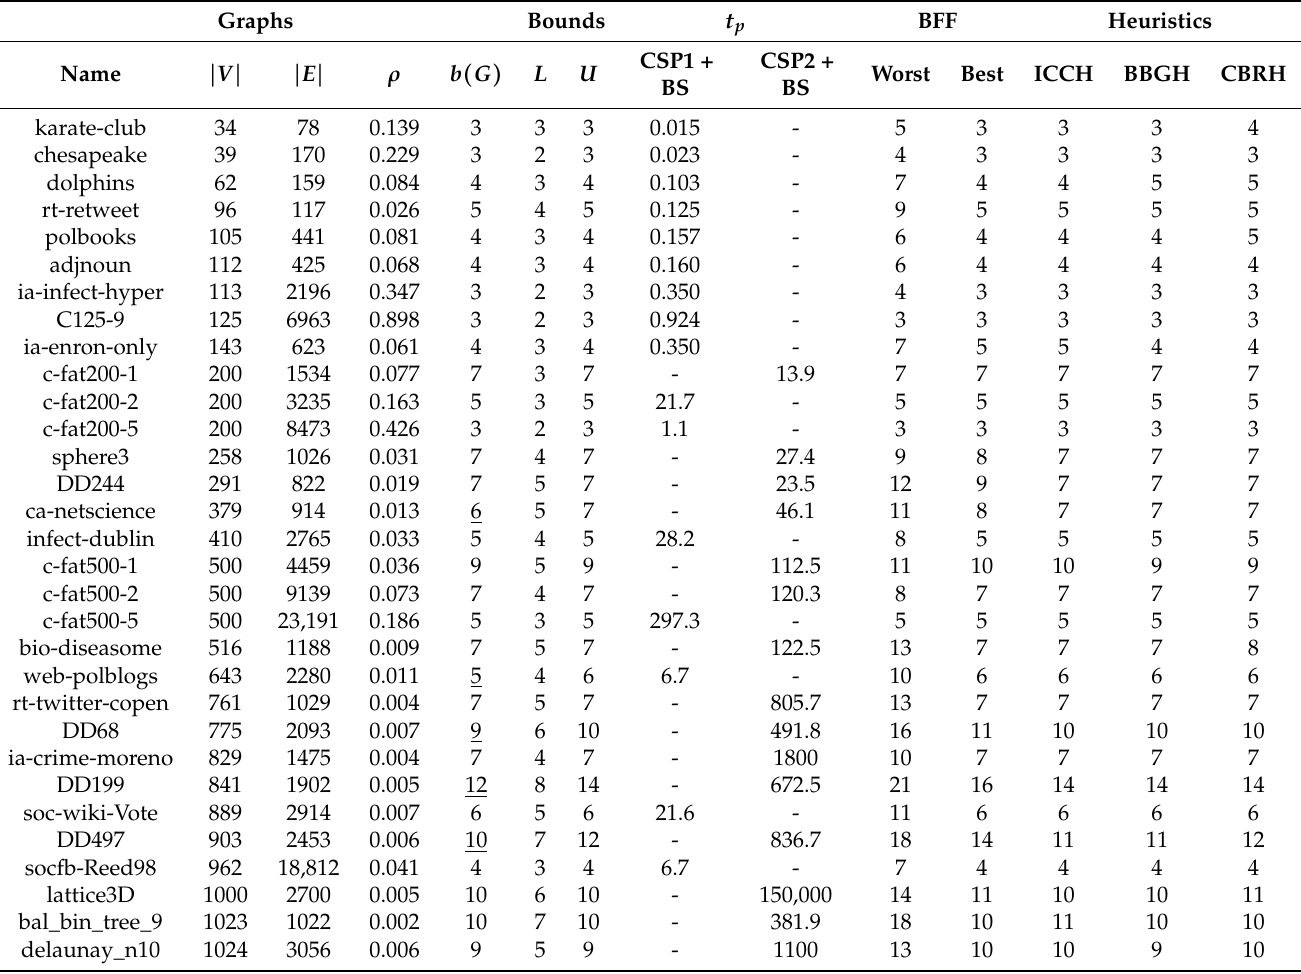
Table 3. Optimal solutions found by CSP1 + BS and CSP2 + BS over some benchmark graphs. The feasible solutions found by some state-of-the-art algorithms are reported too. Optimal solutions reported for the first time are